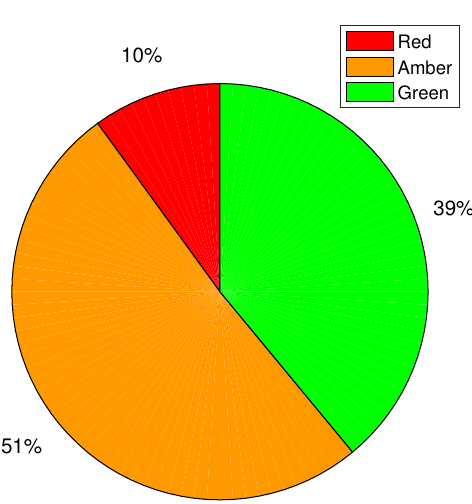
Figure 3. Charging distribution according to the tariff.